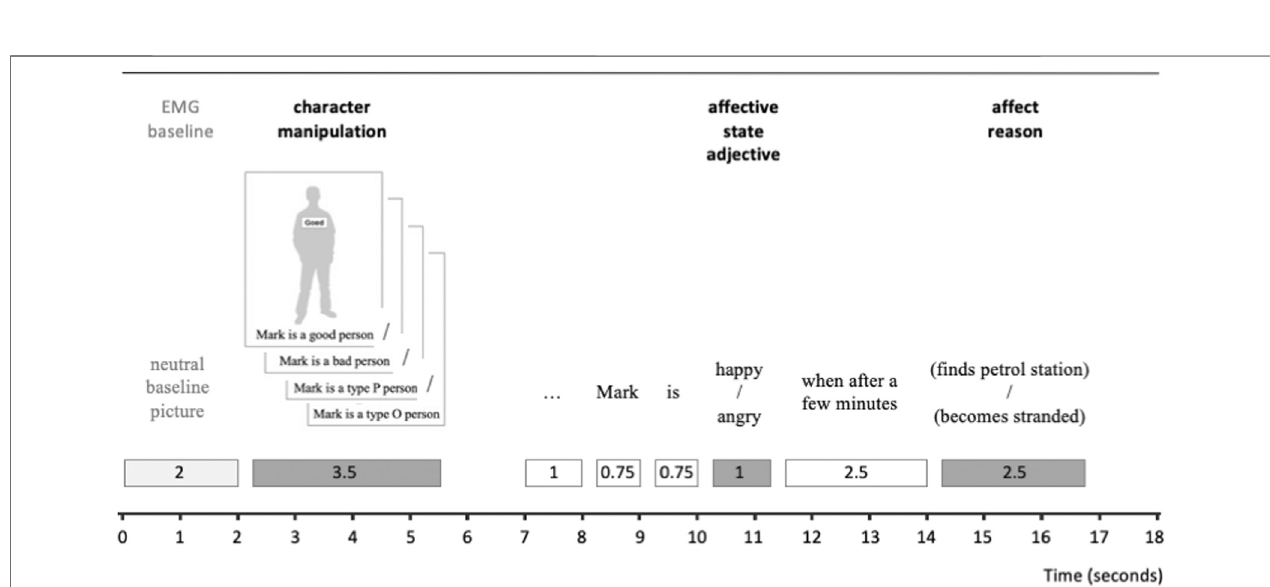
FIGURE 2 | Schematic trial structure, with (partly abbreviated) example item, component presentation duration in seconds, and associated EMG segment labels.